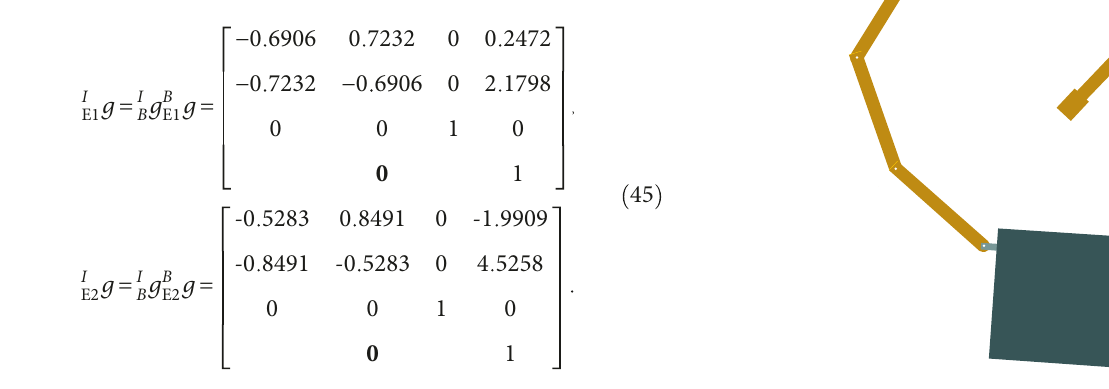
Figure 3: The fi nal con fi guration of the Adams